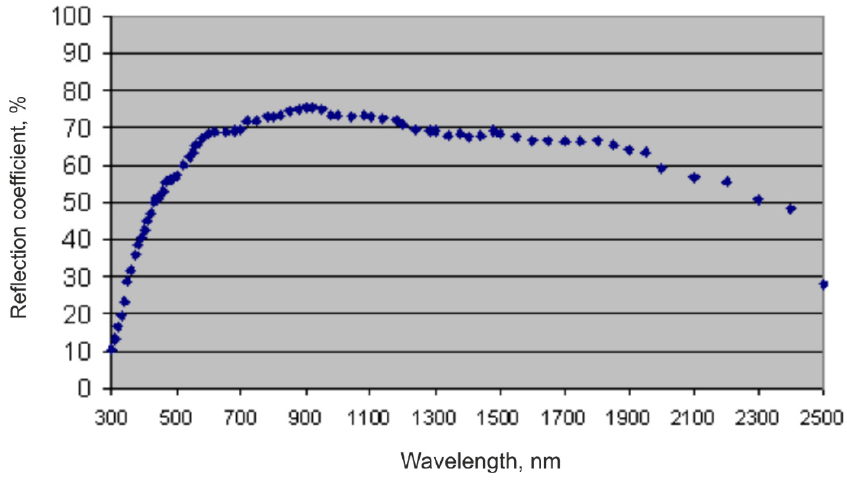
Figure 1. Reflection coefficient of paper versus laser radiation wavelength (for sheet of a Russian typographic book of the beginning of the XIX century made of wood pulp).